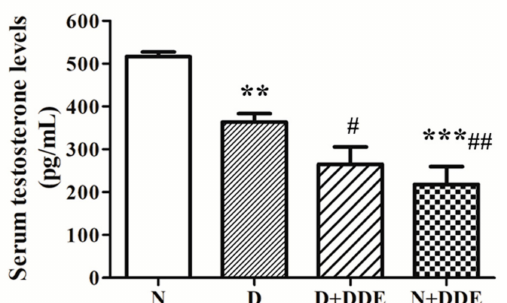
Figure 8. Analysis of serum testosterone levels. The results were graphically represented as pg / mL of testosterone content in rat serum. The data were calculated as media ± standard deviation. One-way ANOVA analysis showed significant di ff erences between treated and controls: ** p < 0.01 vs. N; *** p < 0.001 vs. N; # p < 0.05 vs. D; ## p < 0.01 vs. D. Two-way ANOVA analysis indicated significant diet e ff ect, extremely significant DDE e ff ect, and extremely significant interaction (Bonferroni Post-hoc test: p < 0.001 D vs. N).